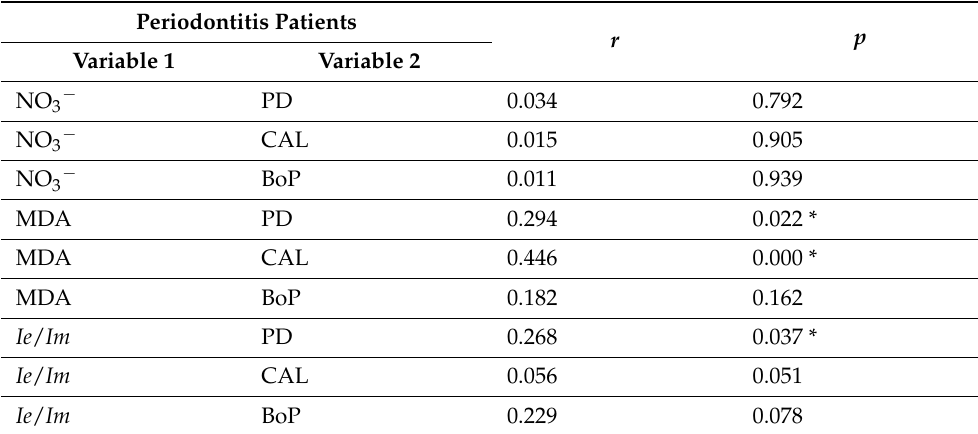
Table 2. Spearman correlation between clinical parameters and markers of oxidative